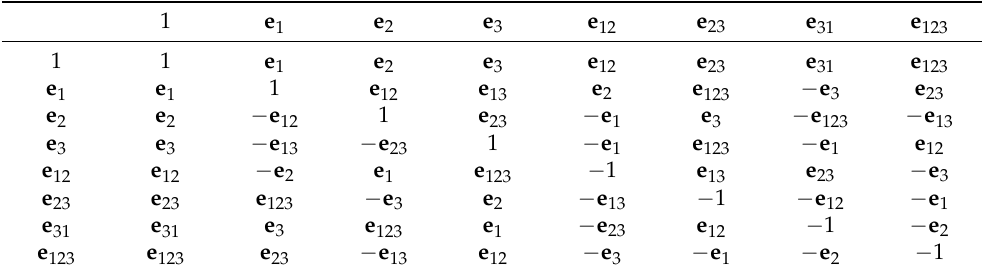
Table 1. The geometric product of basis elements of R 3